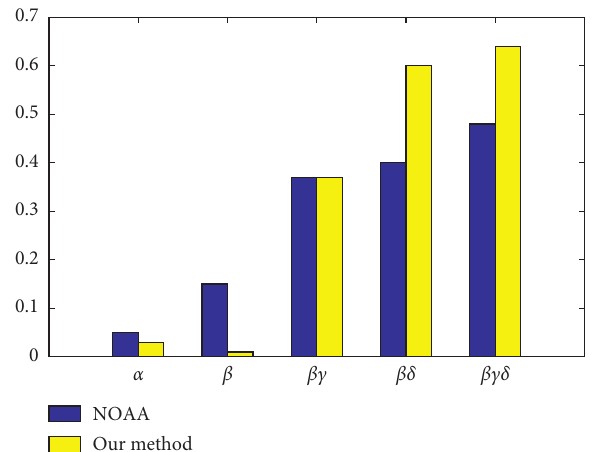
Figure 10: The flare productivities of various types of sunspot groups detected by our method and NOAA in 2014 ( I